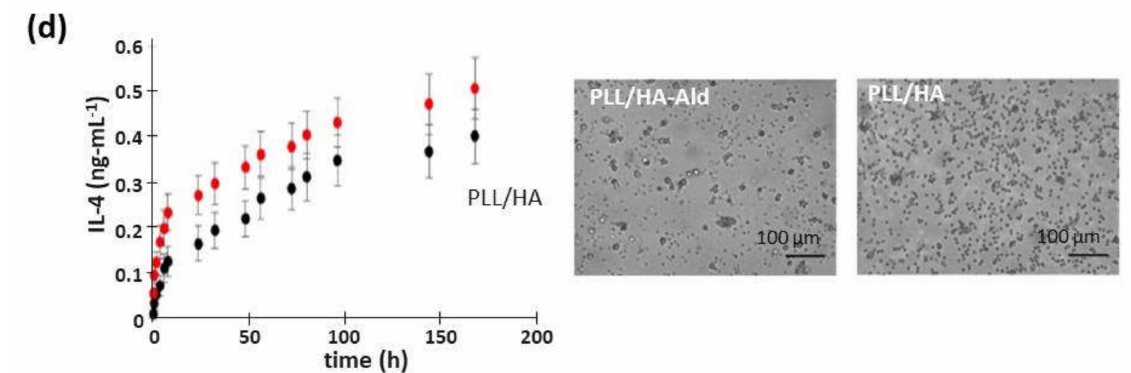
Figure 8. ( a ) Diffusion of FITC-dextran (FD) of different molecular weights (4, 40, and 70 kDa) through a (CHI/ALG) 100 film (left) and CLSM images (right) (Reprinted with permission from [47]; Copyright 2013 American Chemical Society); ( b ) Schematic representation of drug delivery from multilayer films and cumulative release profiles of tamoxifen (TMX) from (ALG/CHI) 5 TMX(CHI/ALG) m (m = 5 ( (cid:4) ), 10 ( • ), and 20 ( (cid:78) )) films, where the inset shows the fitting to the Ritger-Peppas model, (left) and percentage of MCF-7 cell viability after tamoxifen (TMX) release from these films comparing with control films without TMX (right) (Adapted and reprinted with permission from [120]; Copyright 2018 Elsevier Ltd.); ( c ) Release profiles of bFGF reservoirs assembled with 3LP or 6LP and from co-solutions with bFGF at 0.1 or 1 µ g/mL (left) and NIH/3T3 fibroblasts proliferation on FGF reservoirs with 6LP (right) (Adapted and reprinted with permission from [126]; Copyright 2015 Elsevier B.V.); ( d ) Kinetic of IL-4 release from PLL/HA and PLL/HA-Ald films in PBS (left) and phase contrast images (right) of monocytes seeded on the films after 6 days in presence of IL-4. Scale bar = 100 µ m. (Adapted and reprinted with permission from [128]. Copyright 2016 American Chemical